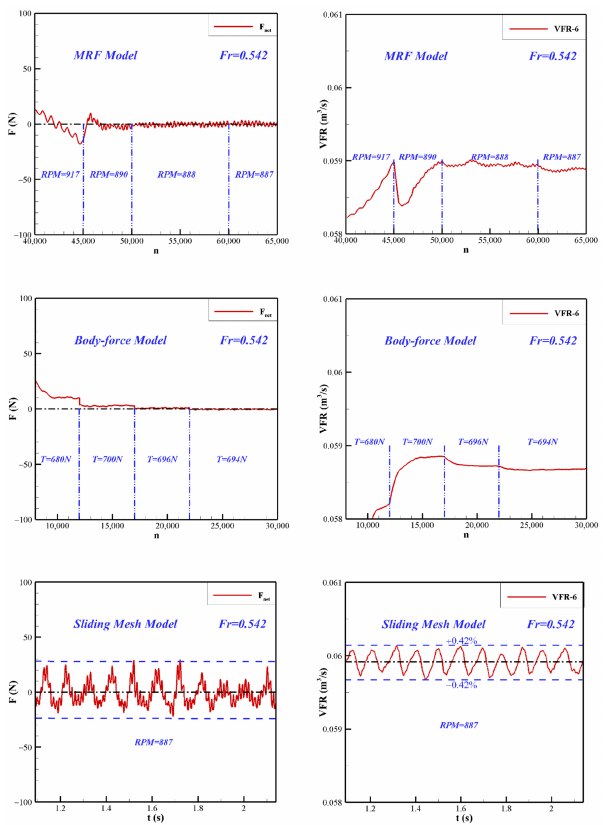
Figure 19. Net force of waterjet-propelled ship and volume flow rate at station 6 (VFR-6) with three different models.